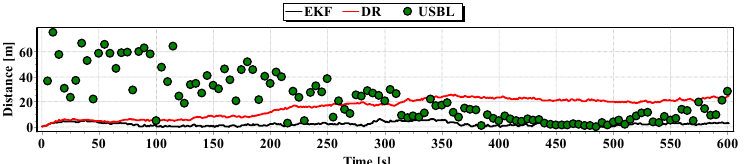
Figure 13. Graph of the reference position distance from the position estimated by EKF and DR methods and determined by the USBL system (single passage).